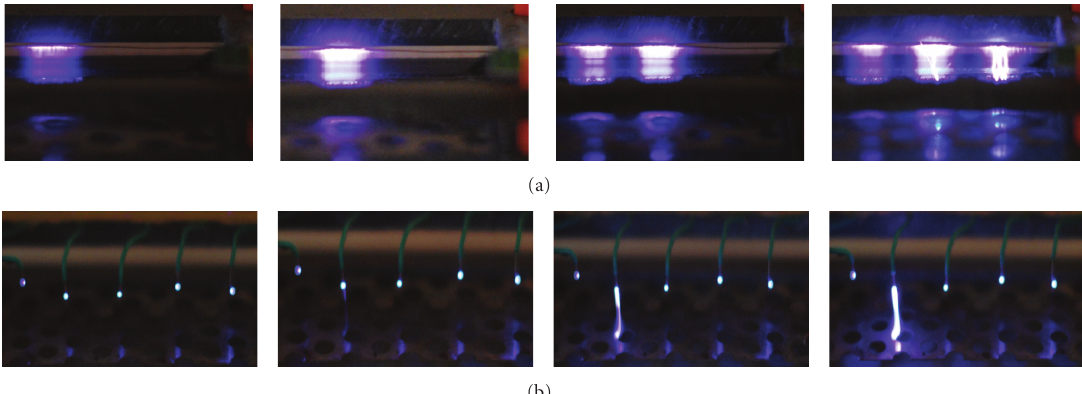
Figure 7: Corona discharge variation with the increase of applied voltage for the di ff erent electrode system. (a) Corona discharge variation with the increase in applied voltage for the line-to-plate electrode system. (b) Corona discharge variation with the increase in applied voltage for the pine-to-plate electrode system.